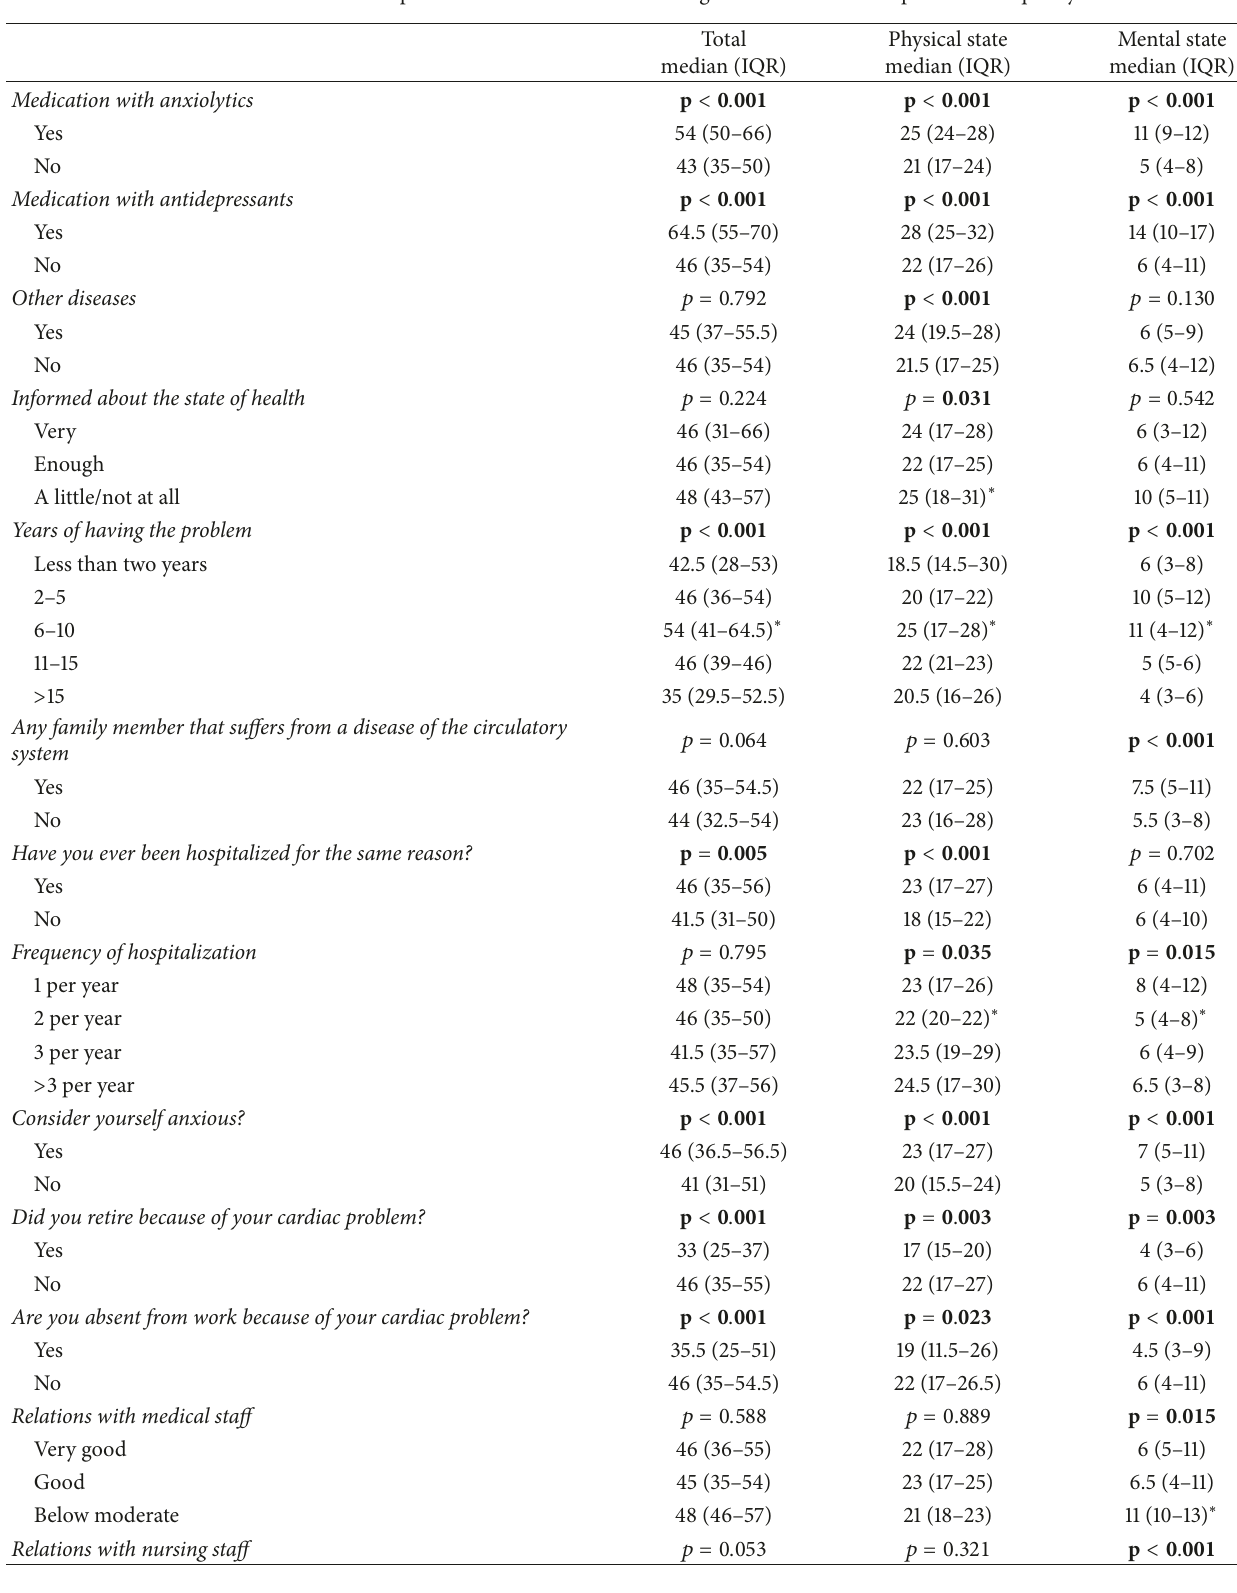
Table 5: Associations between patients characteristics concerning the state of health of patients and quality of